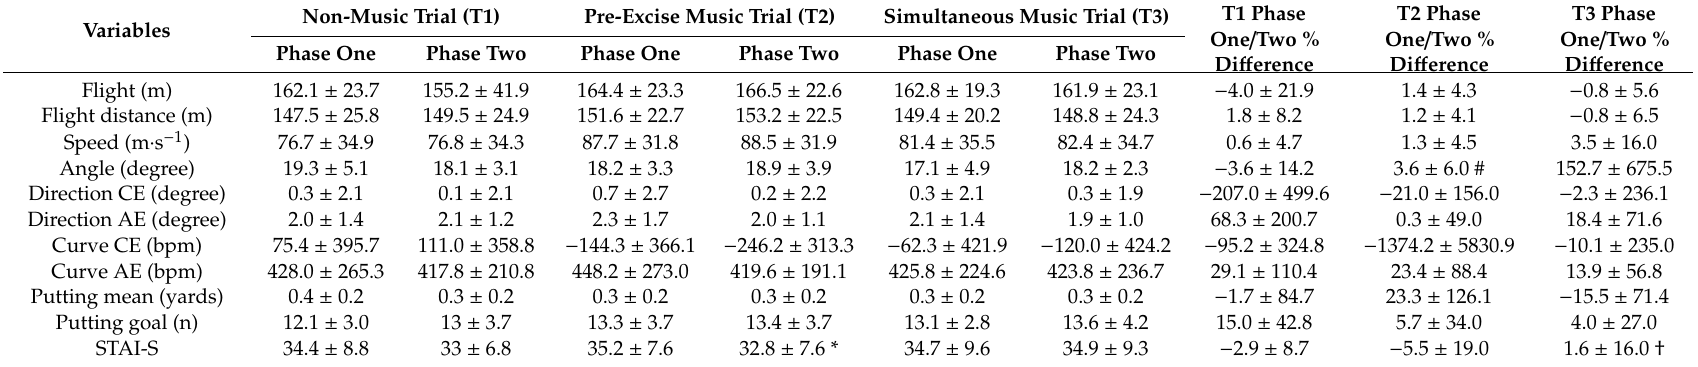
Table 2. Descriptions of golf swing, golf putting, and anxiety level in non-music, pre-exercise music, and simultaneous music